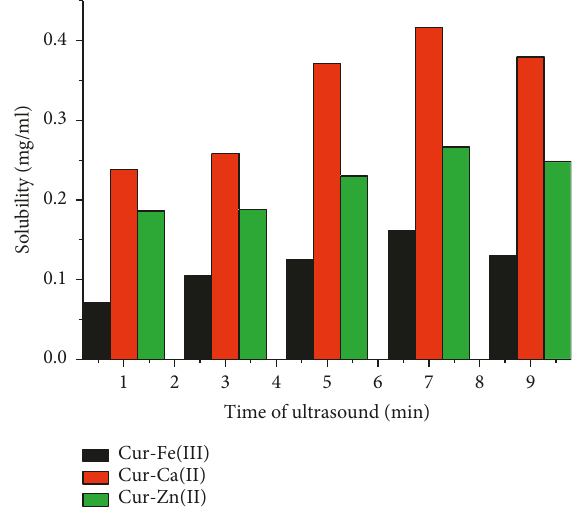
Figure 6: The effect of ultrasonic wave time on the dissolution of curcumin metal